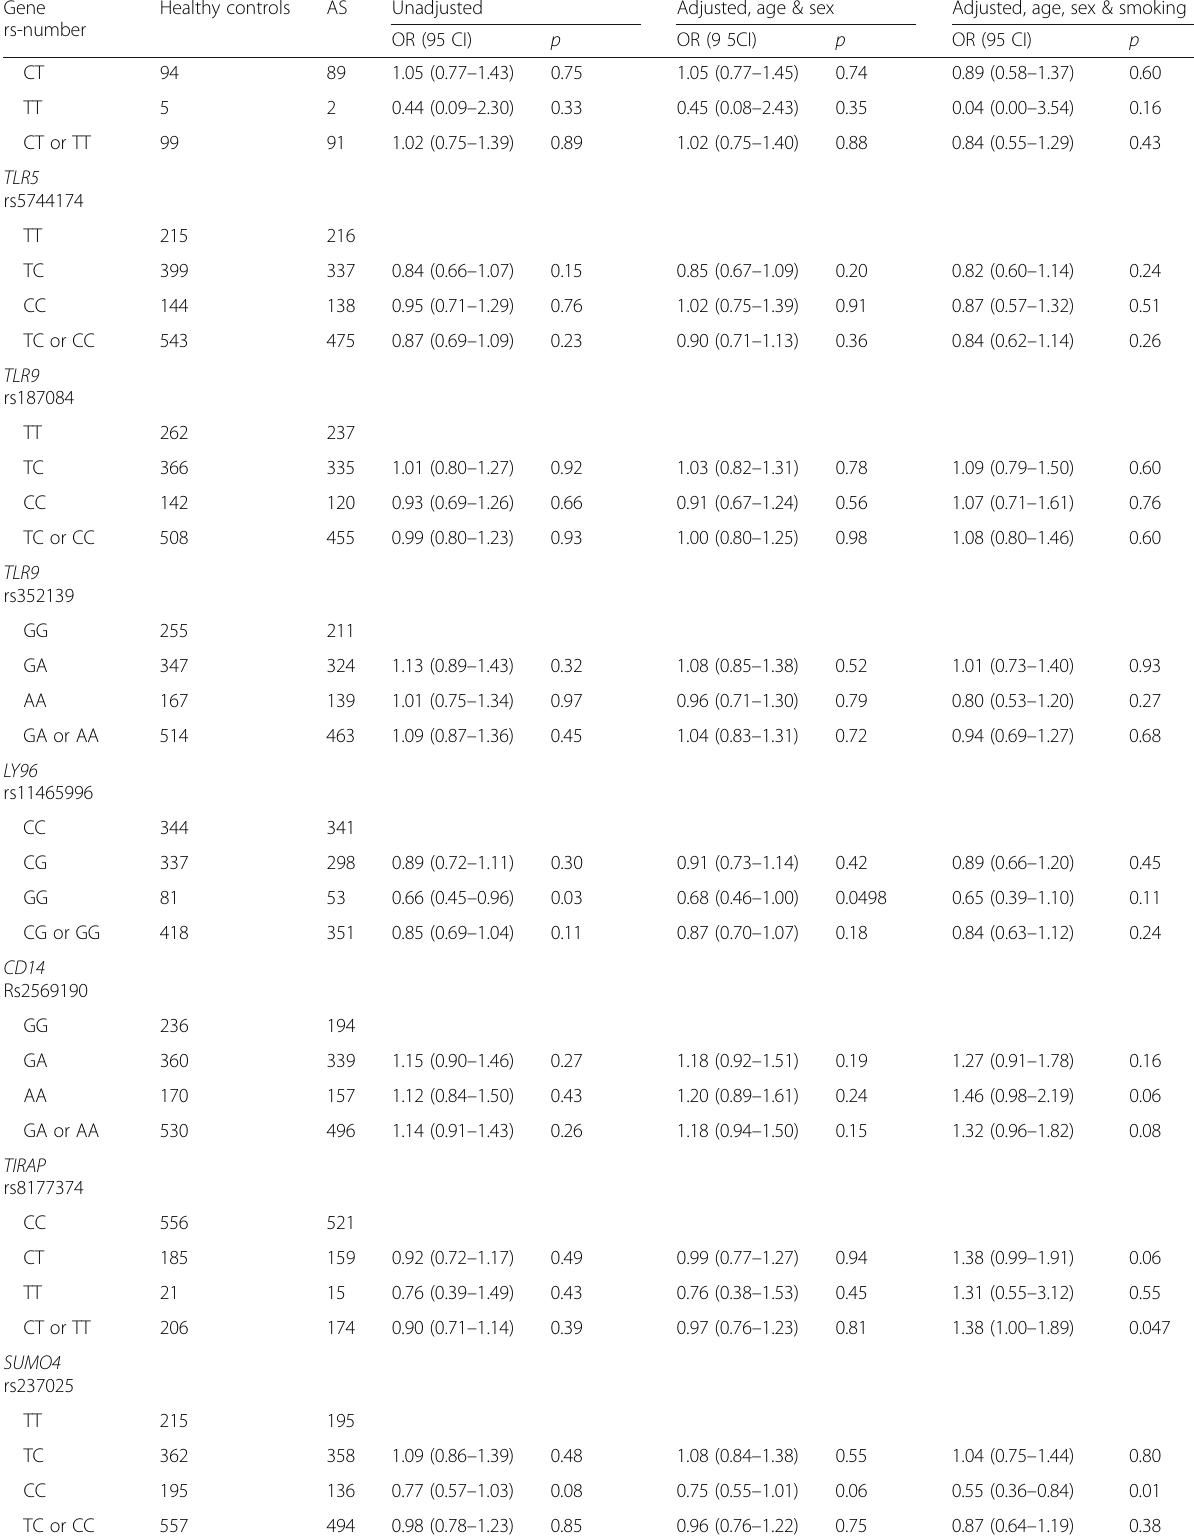
Table 1 Odds ratios (OR) and 95% confidence interval (95CI) for genotypes studied among healthy controls and patients with ankylosing spondylitis (AS)